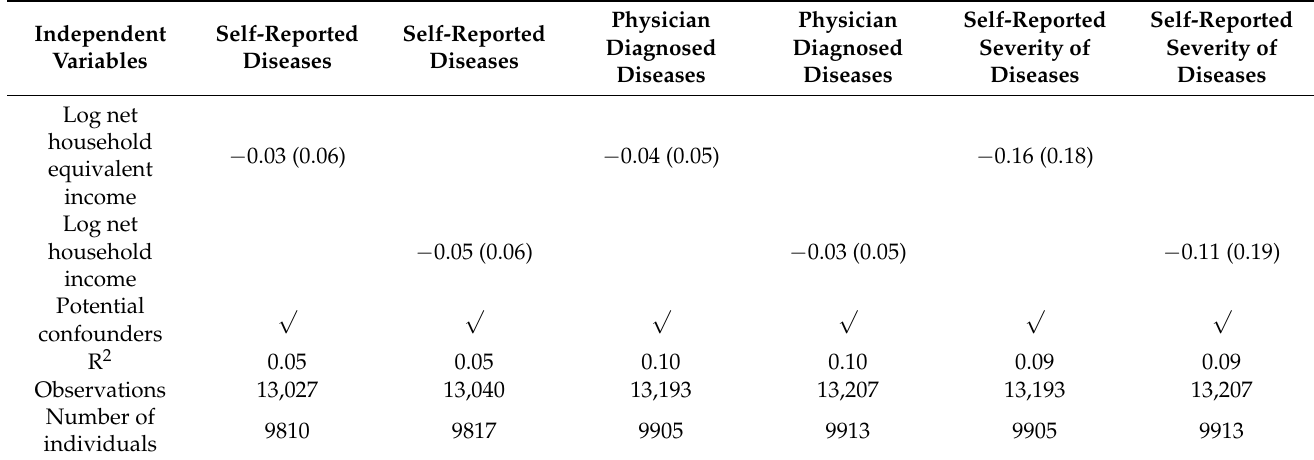
Table 2. Determinants of morbidity. Results of linear fixed-effects regressions.